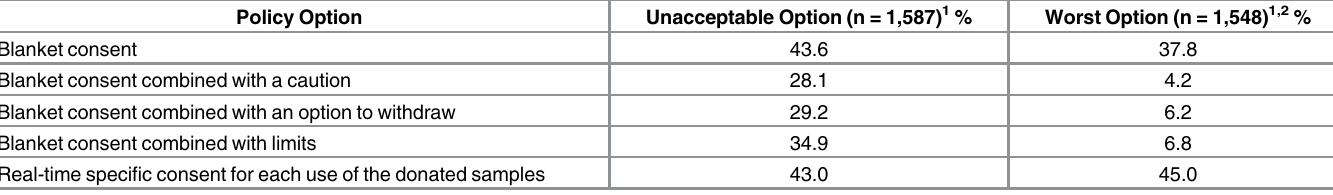
Table 3. Percent finding societal consent policy “ unacceptable ” or “ worst ”